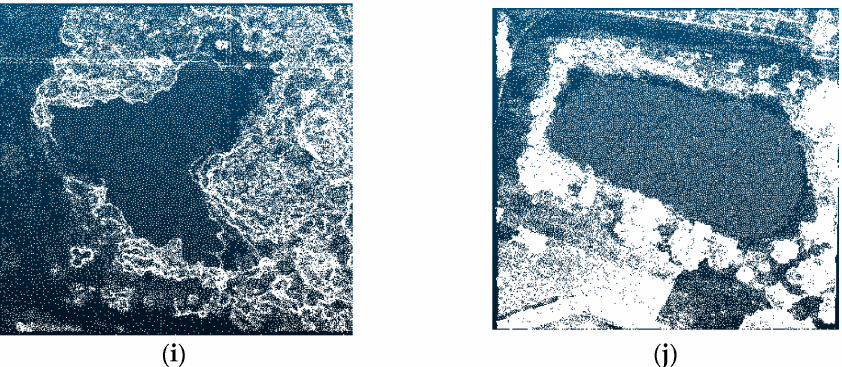
Figure 6. Results of 3D point clouds transformation of the ten experimental 3D models. ( a – j ) are the 3D point clouds of model_01, model_02, model_03, model_04, model_05, model_06, model_07, model_08, model_09 and model_10, respectively.